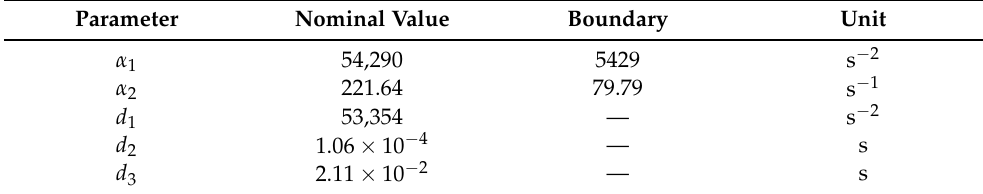
Table 6. Nominal values and boundaries of the reformed plant’s parameters.